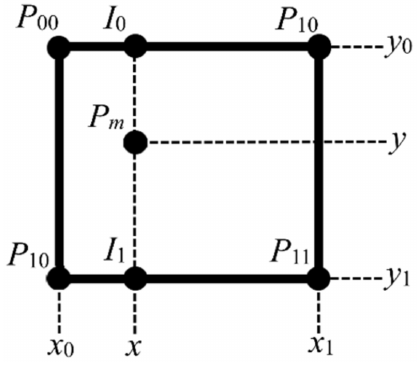
Figure 9. The occupancy grid